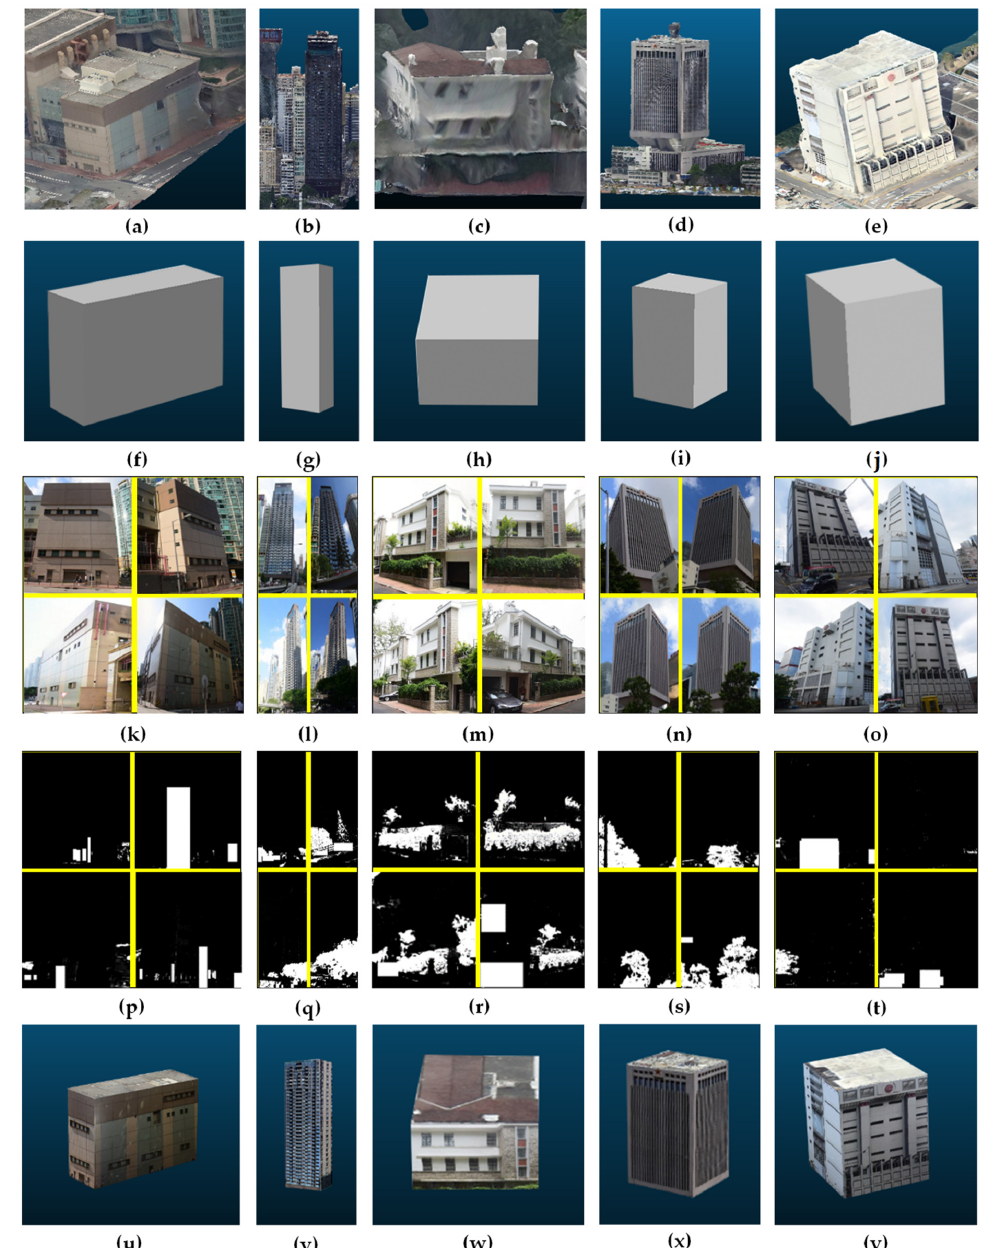
Figure 8. Typical textured building models and multiview texture images. ( a – e ) are five textured building models, and ( f – o ) are examples of texture images with different viewpoints and LOD CityGML building models corresponding to ( a – e ). ( p – t ) are object occlusions, marked by white regions, detected by combining NanoDet and GGLI corresponding to ( a – e ). ( u – y ) are five textured building models by texture mapping using the proposed approach corresponding to ( a – e